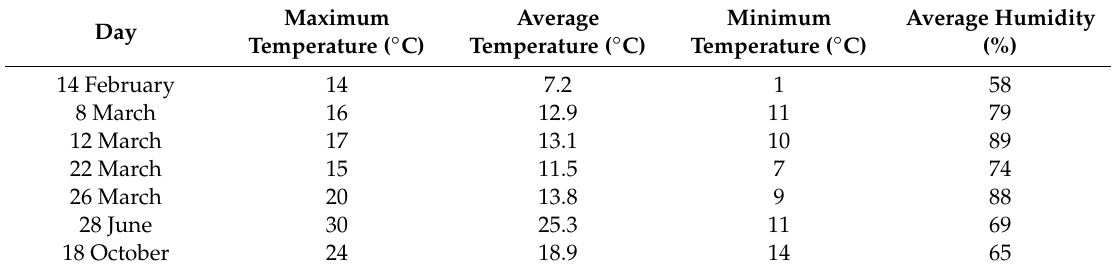
Table 1. Weather conditions in Valencia for represented days in building